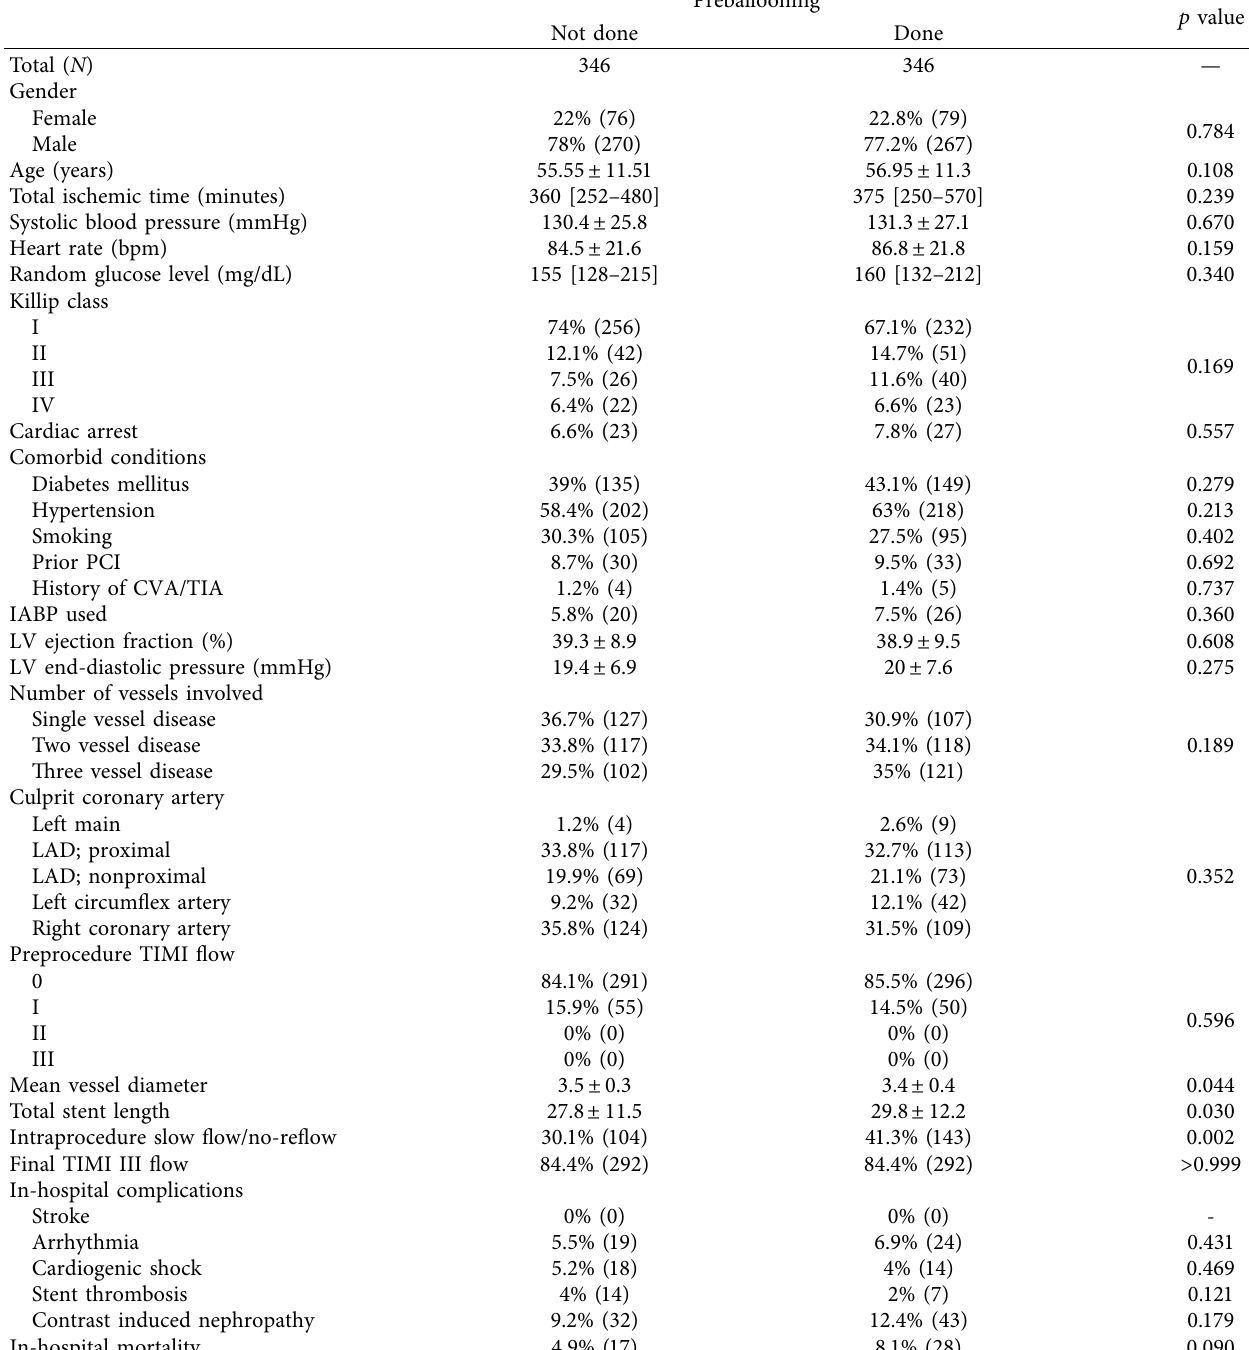
Table 2: Demographic, clinical, and angiographic characteristics and postprocedure in-hospital complications and outcomes’ comparison between propensity-matched cohorts of patients with and without predilation ballooning in 1:1